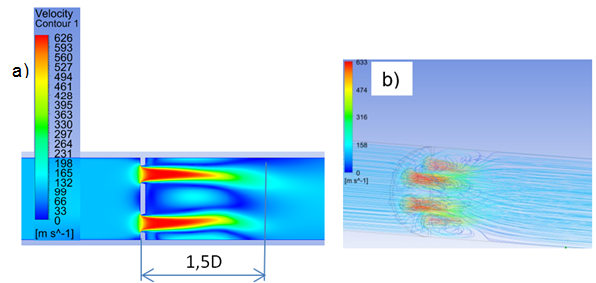
Figure 10: Velocity vectors for a multi-nozzle orifice, a) view in the plane of the cross-section, b) axonometric view